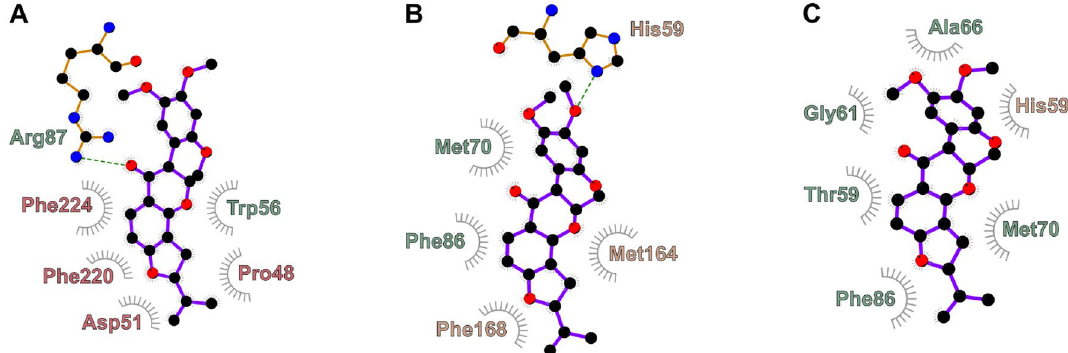
Figure 2. Rotenone contacts to residues in complex I with high interaction energies at binding modes ( A ) ROT2, ( B ) pre-redox and ( C ) ROT1. Residue names are colored as their subunits in Fig.